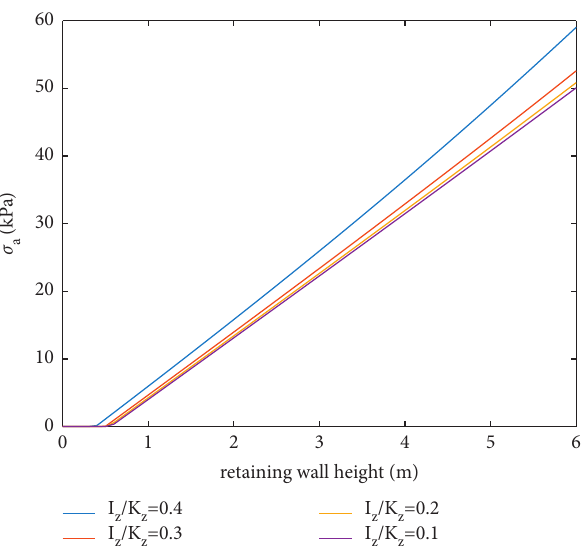
Figure 5: E a changes with standardized infiltration rate. a with rainfall